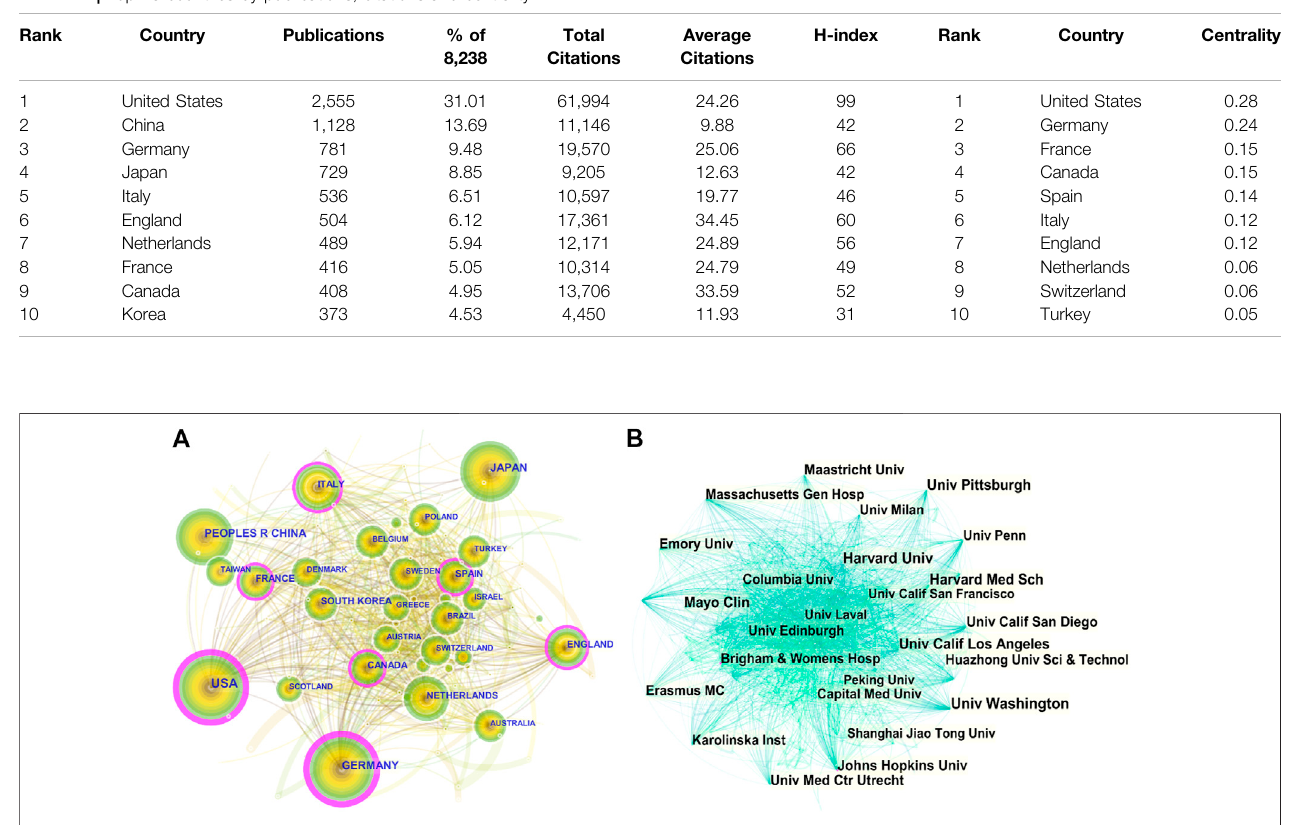
TABLE 1 | Top 10 countries by publications, citations and centrality.